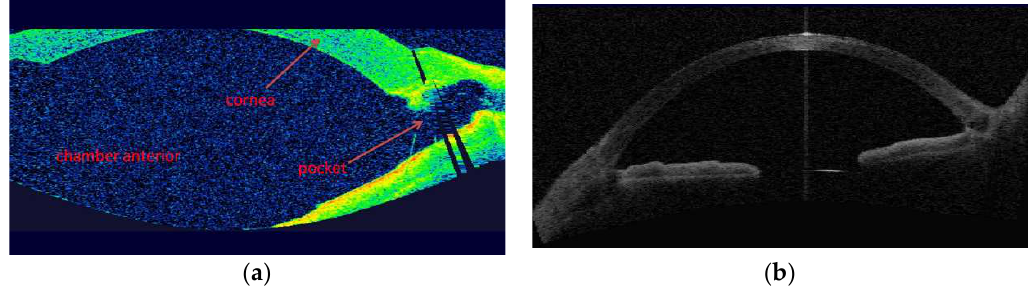
Figure 5. ( a ) OCT image of the anterior chamber: Overview after HFDS procedure with a newly created pocket in the chamber angle (Visante OCT, Zeiss, Oberkochen, Germany). ( b ) OCT image of the anterior chamber of a normal angle anterior before HFDS surgery.